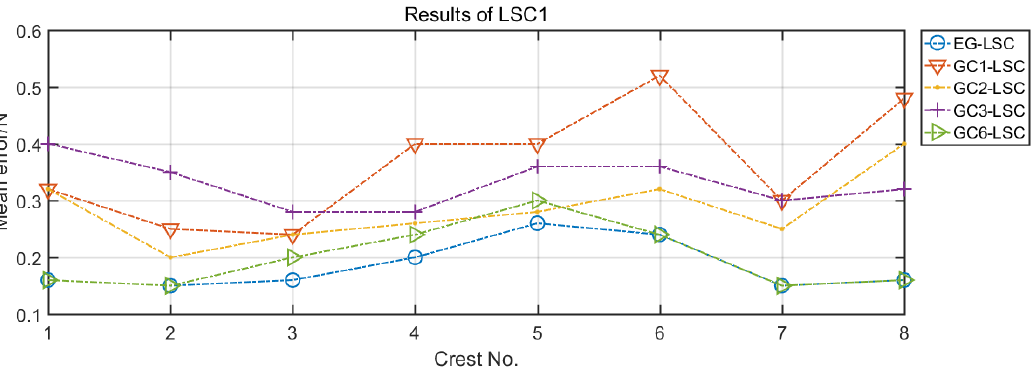
Figure 12. LSC1 results with different algorithms.